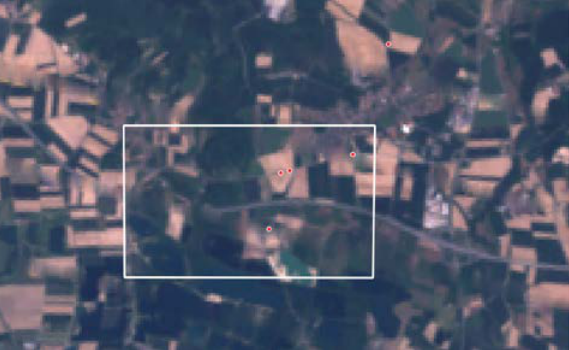
Figure 6 Detail of a Landsat image for day 214 year 2012 (white rectangle indicates borders of the aerial image from Figure 3)